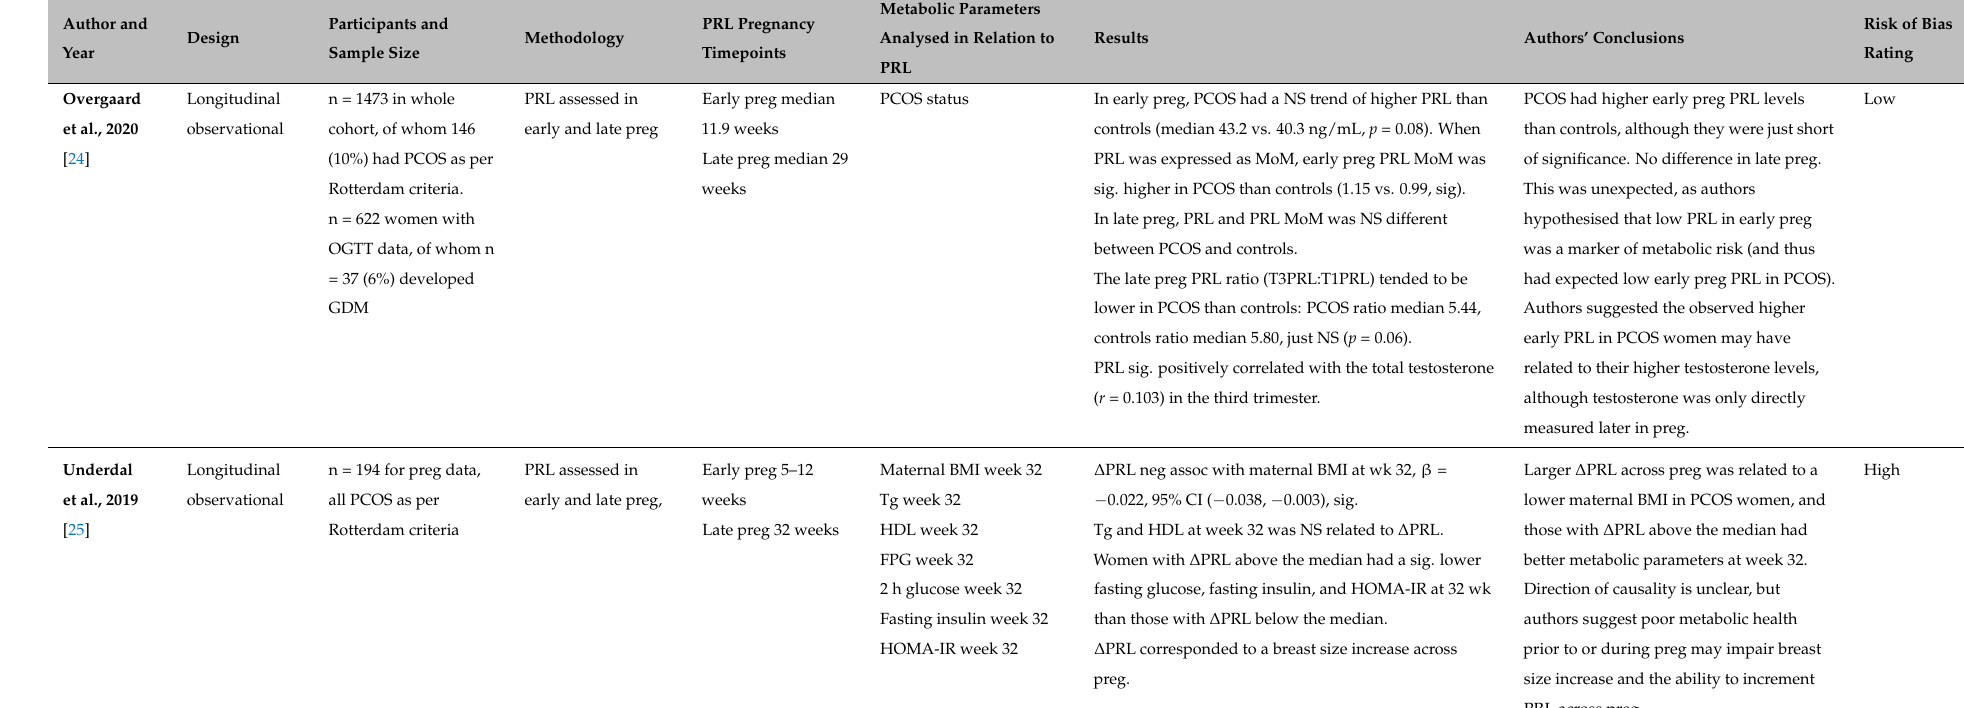
Table A2. Studies examining PRL in relation to PCOS in pregnancy—2